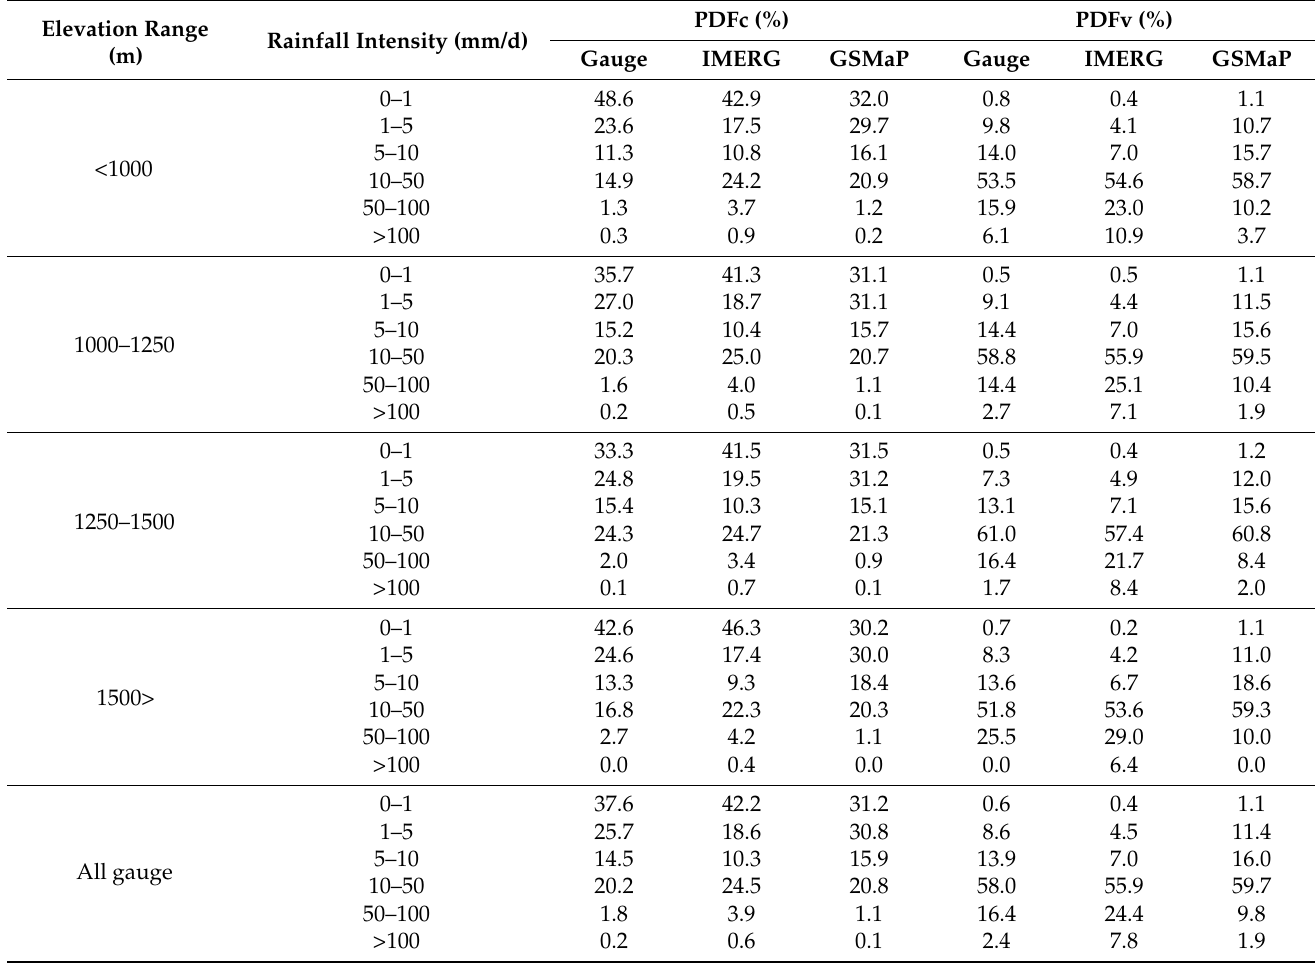
Table 9. Summary of PDFc and PDFv of IMERG, GSMaP and rain gauges over different elevation ranges with different rainfall